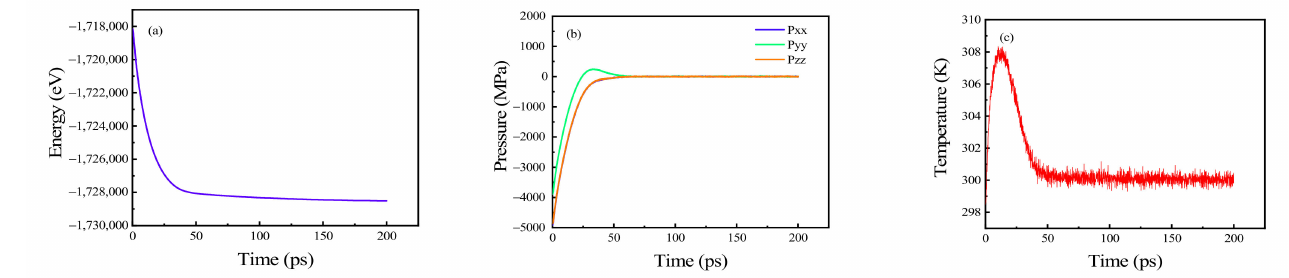
Figure 3. System states after relaxation of ( a ) total energy; ( b ) pressures in x, y, and z directions; and ( c ) temperature.